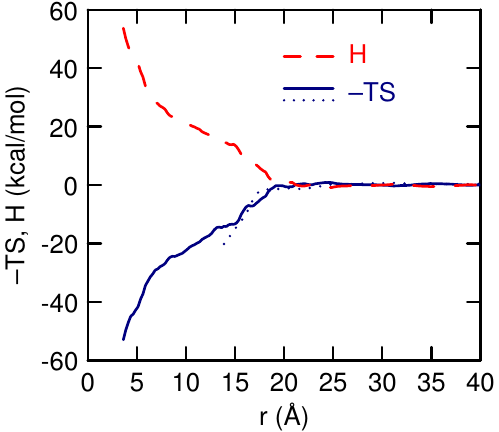
Figure 10. The enthalpy, H, (red dashed lined), and entropy, − S, (blue solid and dotted lines) as a function of The distance between The polymer centers-of-mass at 350 K. The solid line determines S from w ( r ) at 350 and 370 K and the dotted line uses 300 and 350